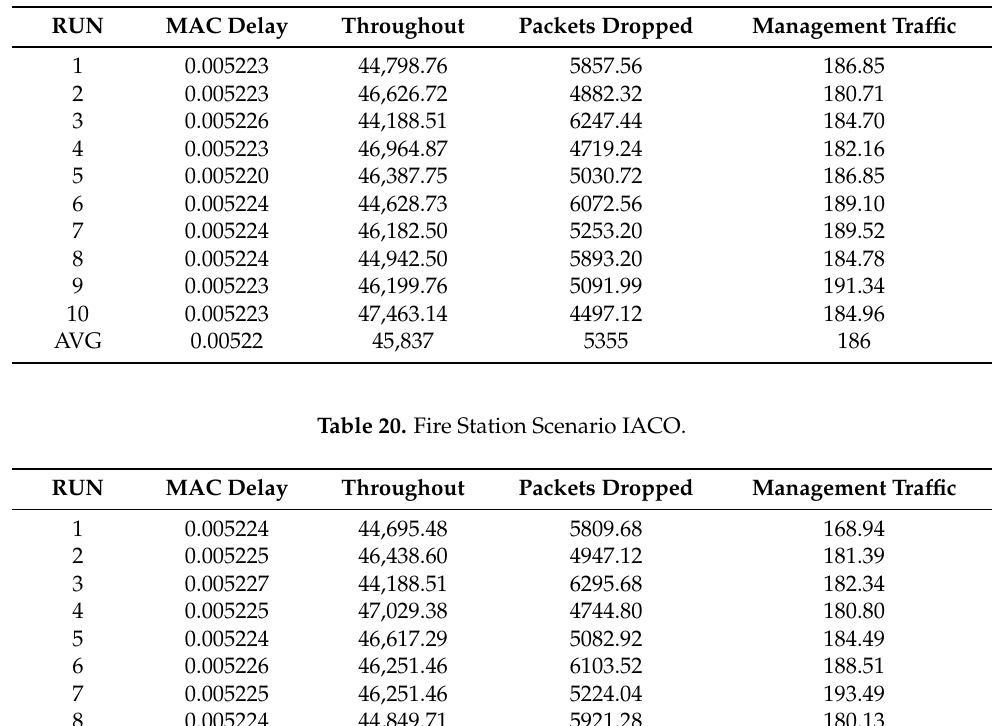
Table 19. Fire Station Scenario ACO.